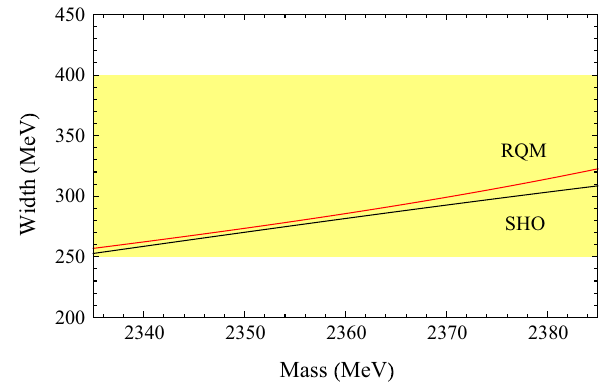
tic quark model is about 2385 MeV [13], close to the η( 2320 ) mass. In the presence of the X ( 2500 ) as the isoscalar member of the 5 1 S 0 meson nonet [6], we shall discuss the possibility of the η( 2320 ) as the isoscalar partner of the X ( 2500 ) .